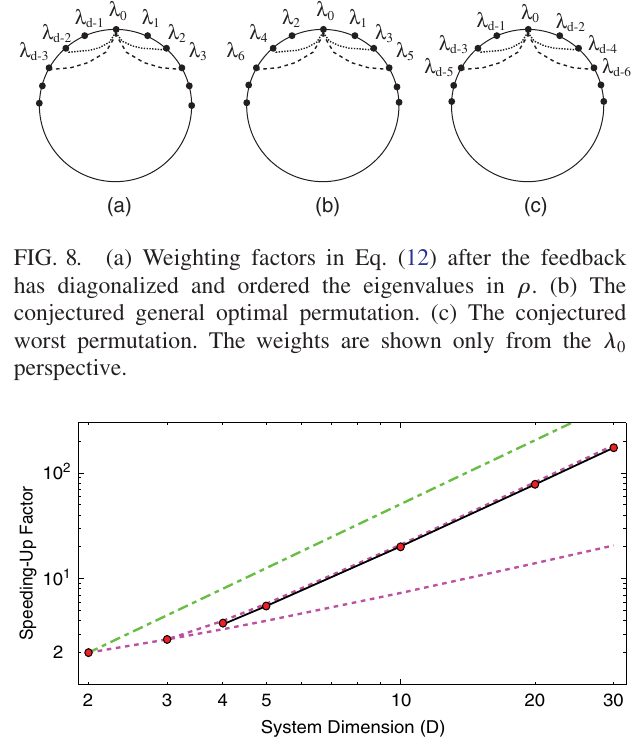
FIG. 9. The asymptotic speeding-up for reaching a given level of purity as a function of the system dimension. The solid black line indicates the fit in Eq. (33). The dashed magenta lines are the upper, Eq. (31), and lower, Eq. (28), bounds derived in the text for the QFT protocol. The dash-dotted green line is the upper bound on all unbiased-basis purification strategies, which is shown on the right-hand side of Eq. (15).